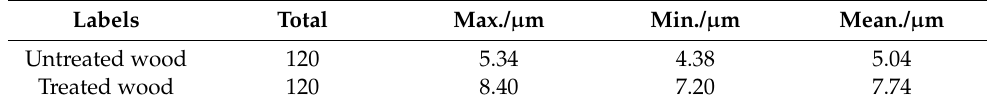
Table 2. The data of untreated and treated wood cell wall thickness. Labels